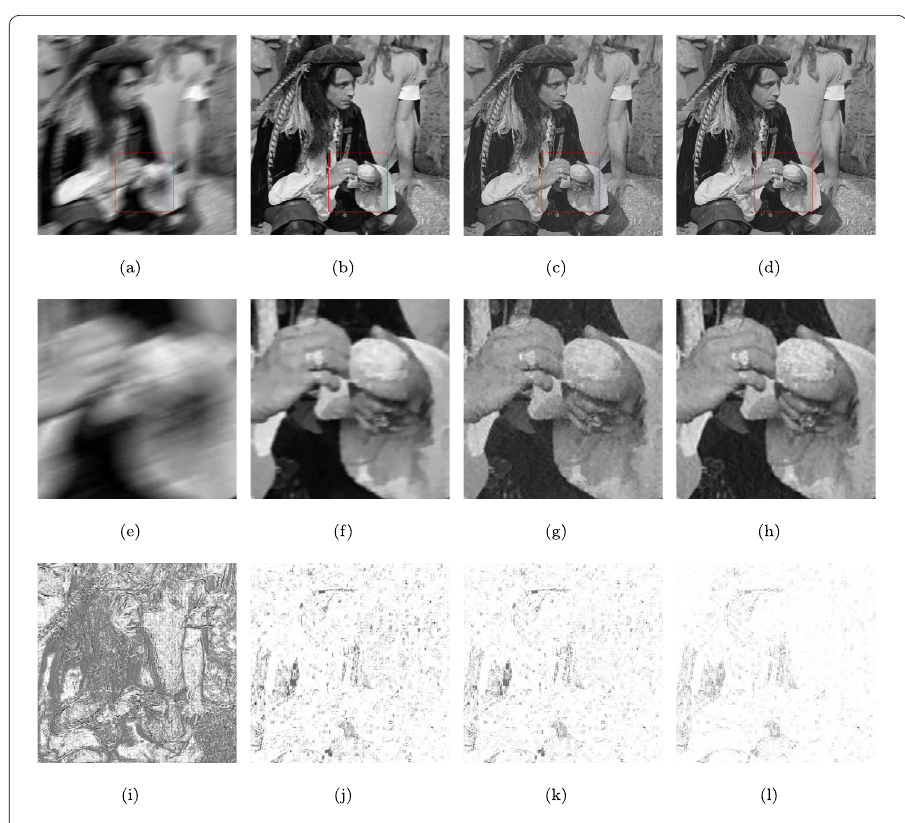
Figure 6 Results of different methods when restoring blurred and noisy image “Man” degraded by motion blur with len = 20 and theta = 20 and a noise with BSNR = 35: ( a ) blurred and noisy image; ( b ) restored image by Fast-TV; ( c ) restored image by FNDTV; ( d ) restored image by our method; ( e ) zoomed part of ( a ); ( f ) zoomed part of ( b ); ( g ) zoomed part of ( c ); ( h ) zoomed part of ( d ); ( i ) SSIM index map of the corrupted image; ( j ) SSIM index map of the recovered image by FastTV; ( k ) SSIM index map of the recovered image by FNDTV; ( l ) SSIM index map of the recovered image by our